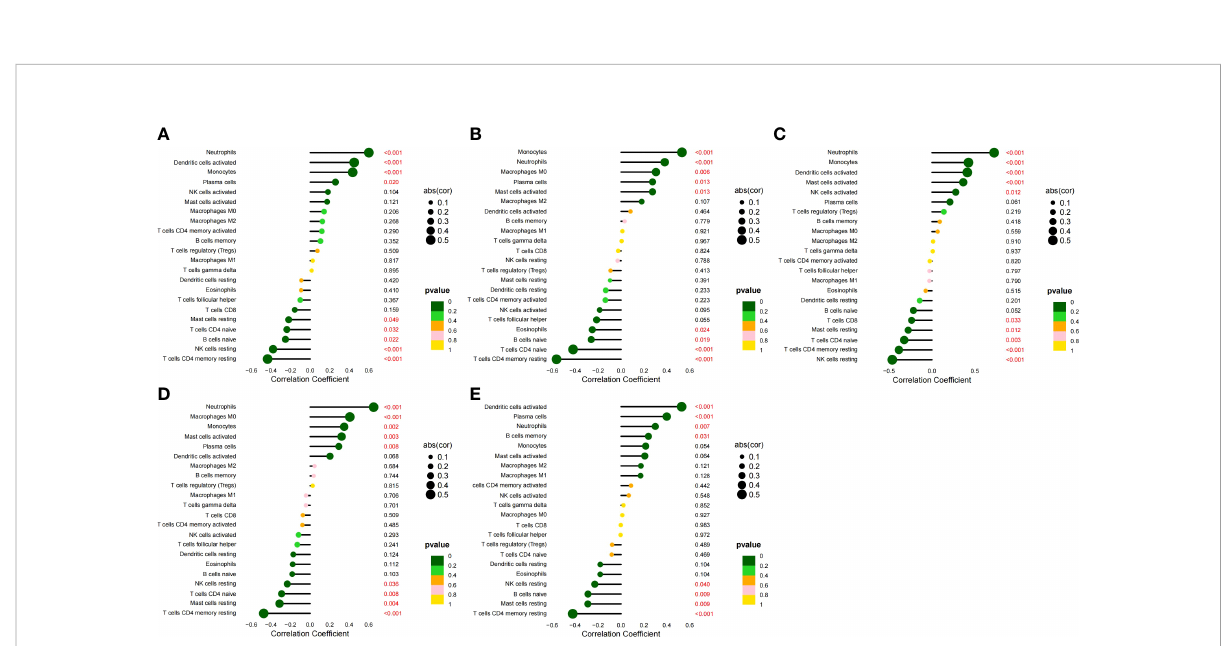
FIGURE 10 Correlation between fi ve HGs and IICs in SLE. (A) Correlation between CCR1 and IICs. (B) Correlation between CD163 and IICs. (C) Correlation between IL1RN and IICs. (D) Correlation between MMP9 and IICs. (E) Correlation between SIGLEC1 and